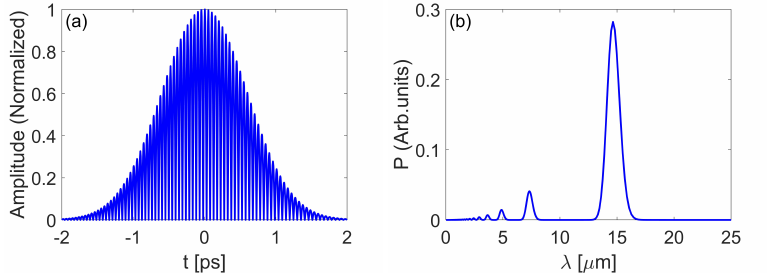
Figure 8. The amplitude distribution ( a ) and spectrum ( b ) of the frequency beating profile with the TOD.